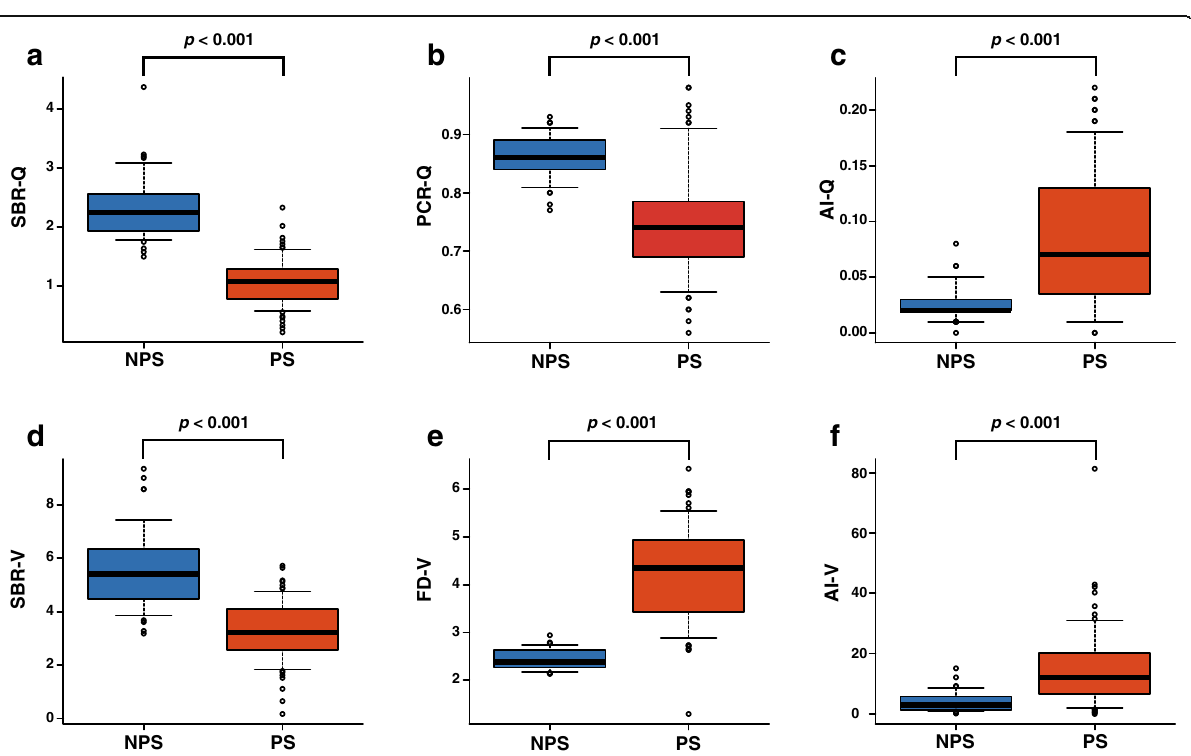
Fig. 2 Box-and-whisker plots of the SBR-Q ( a ), PCR-Q ( b ), AI-Q ( c ), SBR-V ( d ), FD-V ( e ), and AI-V ( f ). There were significant differences in all six quantitative indices between NPS and PS, as assessed using the Mann-Whitney U test. Abbreviations: AI, asymmetry index; FD, fractal dimension; NPS, non-parkinsonian syndrome; PCR, putamen-to-caudate ratio; PS, parkinsonian syndrome; SBR, specific binding